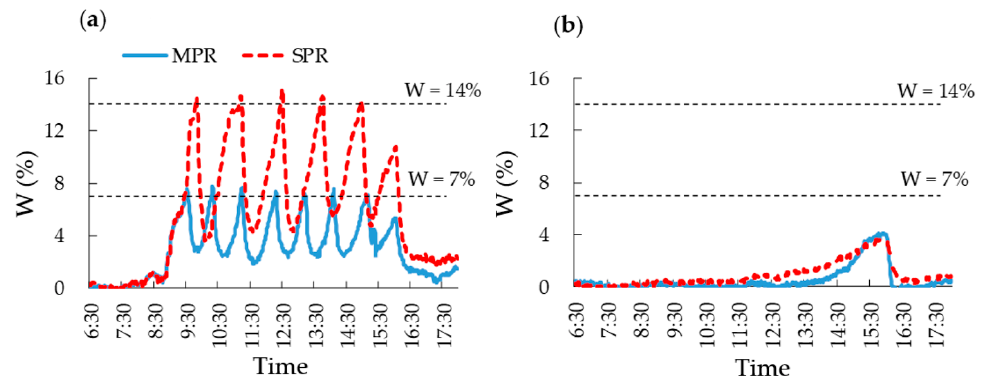
Figure 1. Typical diurnal changes in the wilting ratio (W) in MPR and SPR from 06:30 to 18:00 on a sunny ( a ) and cloudy day ( b ). MPR: moderate wilting–partial recovery treatment. SPR: severe wilting–partial recovery